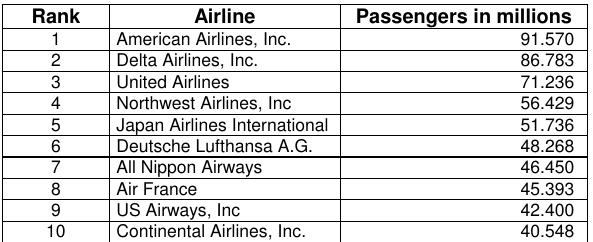
Table 2. The world’s largest airlines in